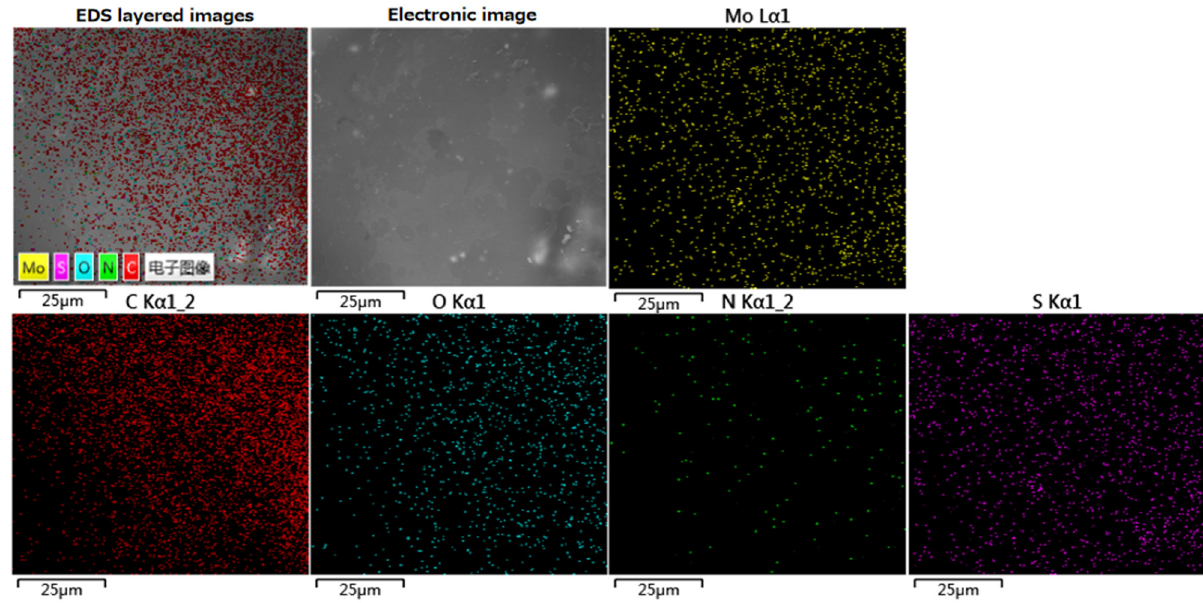
Figure 2. EDS images of 2 wt% RSF/MoS 2 NP hybrid fiber residues after thermal decomposition.